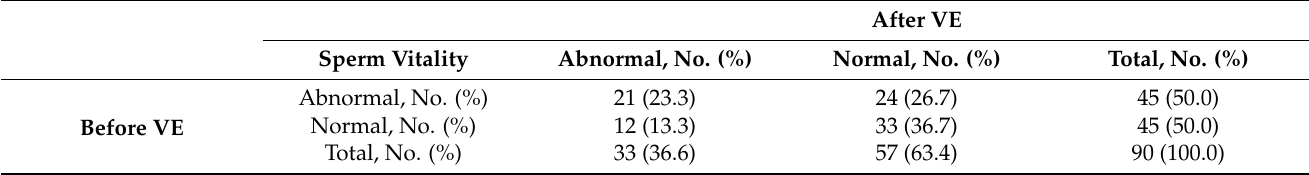
Table 7. Cross-tabulation table showing the number of patients with abnormal and normal sperm vitality in the first semen analysis before varicocele embolization (VE) versus in the second semen analysis after VE.